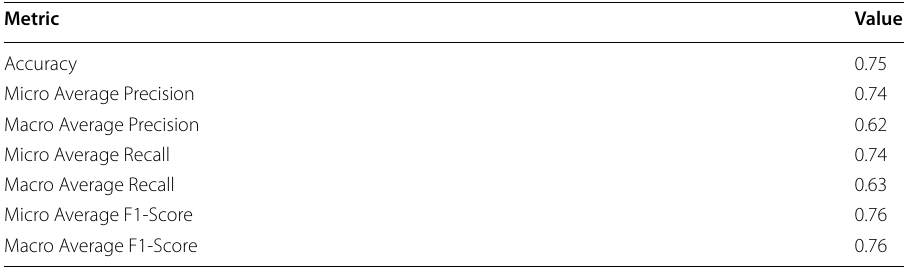
Table 10 Confusion matrix of our classification algorithm with the classical version of the Eros distance Token Contract Exchange Bancor Uniswap Token Contract 1632 88 224 10 Exchange 62 964 72 Bancor 124 523 Uniswap 18 70 484